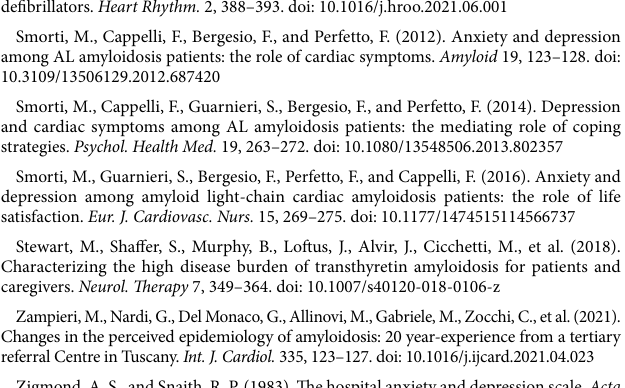
referral Centre in Tuscany. Int. J. Cardiol. 335, 123–127. doi: